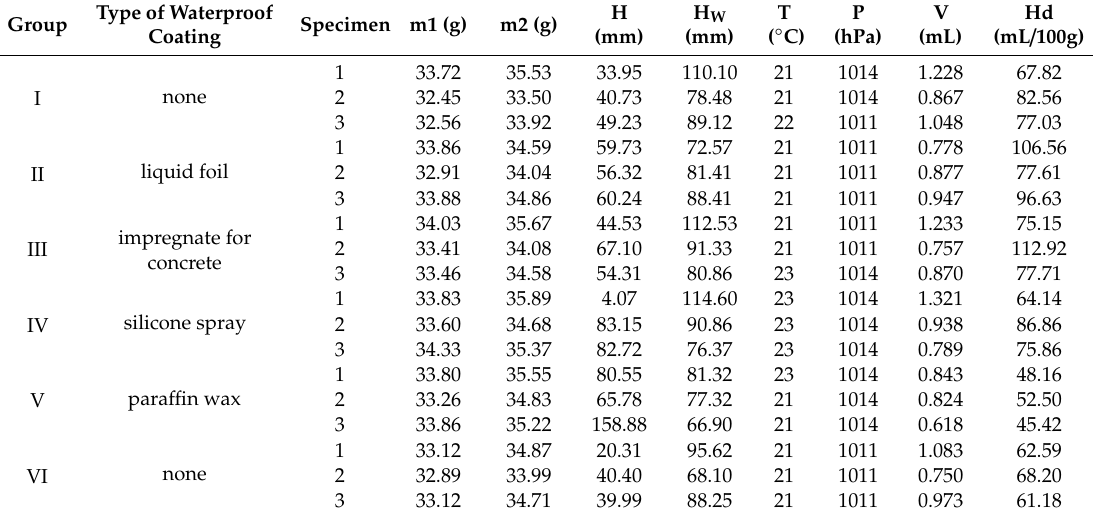
Table 4. Di ff usible hydrogen content measurement results.